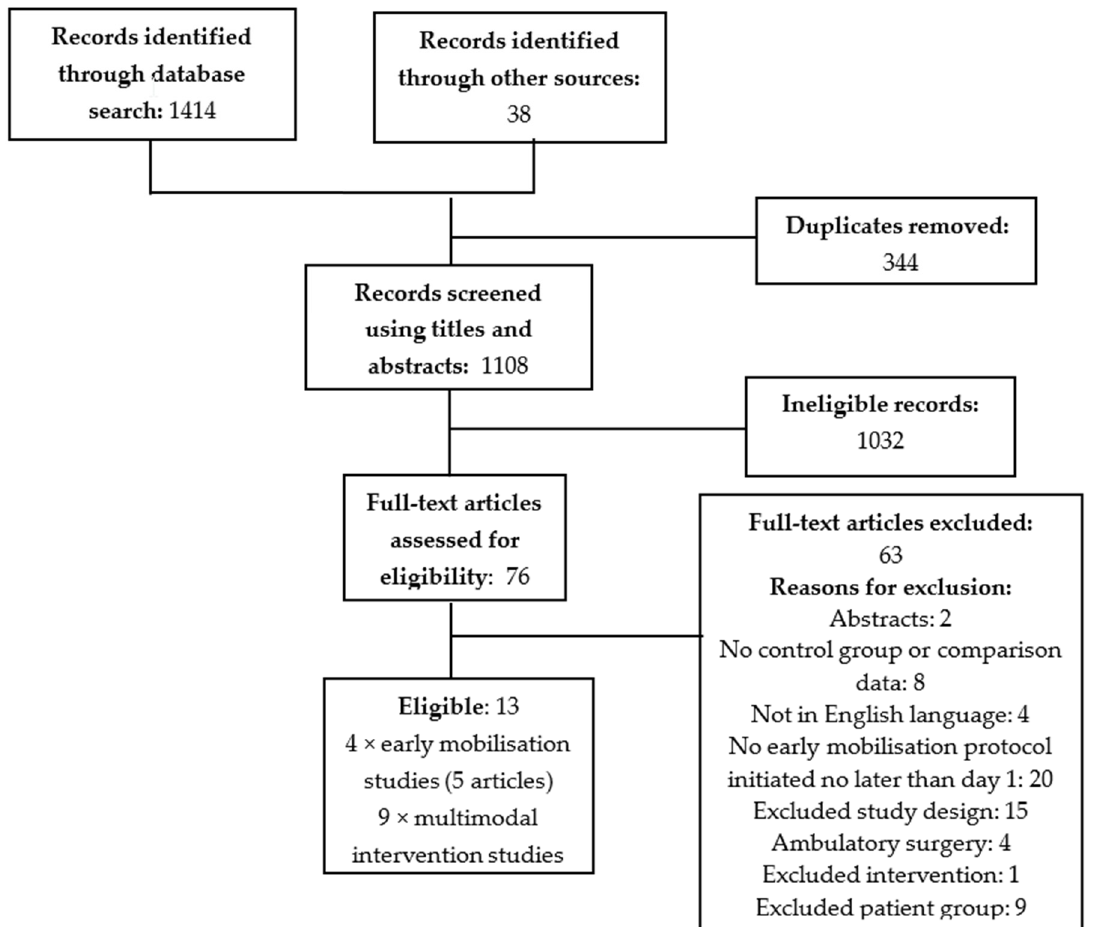
Figure 1. Study identification flow chart (adapted from the Preferred Reporting Items for Systematic Reviews and Meta-Analysis flowchart)